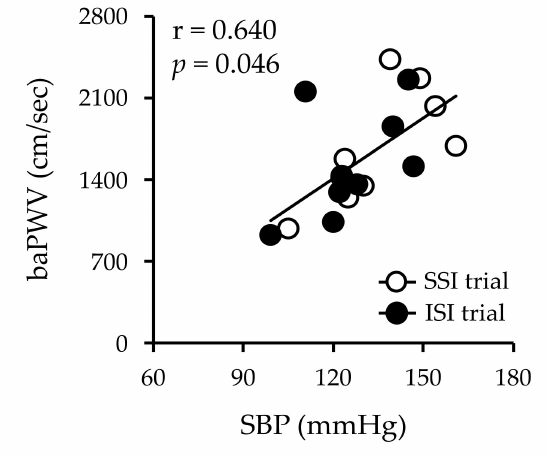
Figure 4. Correlation between arterial stiffness and brachial SBP at 90 min after sucrose and isomal- tulose intake. Values are mean ± SD. r = 0.640 and p = 0.046. SBP, systolic blood pressure; SSI, sucrose solution intake; ISI, isomaltulose solution intake; SD, standard